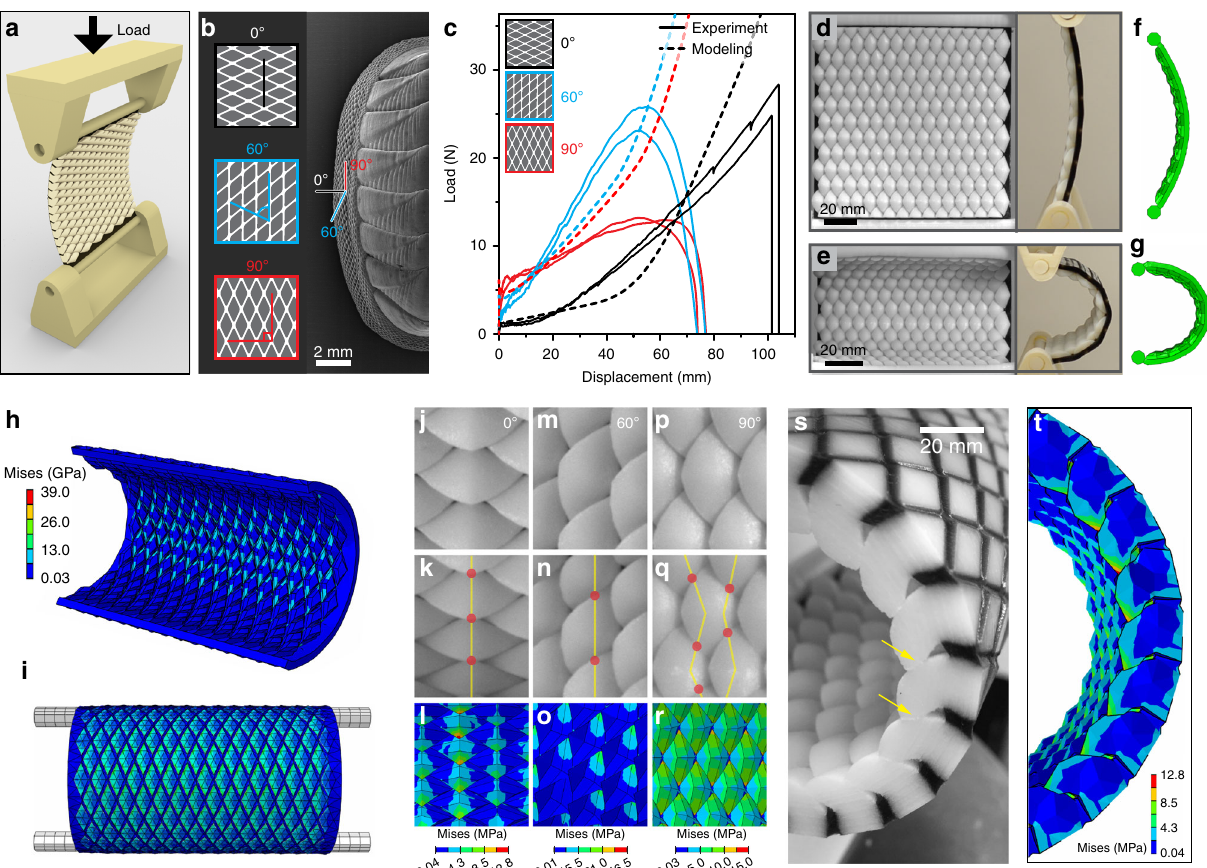
Fig. 7 Analysis of anisotropic fl exibility of the bio-inspired scale armor prototypes. a Schematic diagram of the post-buckling bending experiments. b Left, schematic diagrams of specimens tested in three orientations by varying the angle, φ , which is de fi ned between the loading direction and the width direction of scales. Right, the modeled three φ angles indicated on the chiton ’ s body. c Experimentally measured and corresponding FE predictions of the force – displacement curves for prototypes with φ of 0°, 60°, and 90°. Photos of the φ = 90° sample at displacement of d 0 and e 60 mm, and f , g corresponding con fi gurations from the FE modeling. The left and right photos in d , e show the front and side views, respectively. The distributions of von Mises stress of the φ = 90° sample from h the front and i the back view. Magni fi ed views of the interaction between adjacent scales at displacement of j , m , p 0 and k , n , q 60 mm for φ = ( j , k ) 0°, ( m , n ) 60°, and ( p , q ) 90° sample, respectively. The red dots indicate the interlocking (contact) among adjacent scales. The von Mises stress distributions within individual scales at displacement of 60 mm due to interscale contact for φ = ( l ) 0°, ( o ) 60°, and ( r ) 90° sample, respectively. s A magni fi ed view of the interlocked scales (indicated by yellow arrows) and t corresponding stress distributions from FE analysis for the φ = 0° sample at displacement of 60